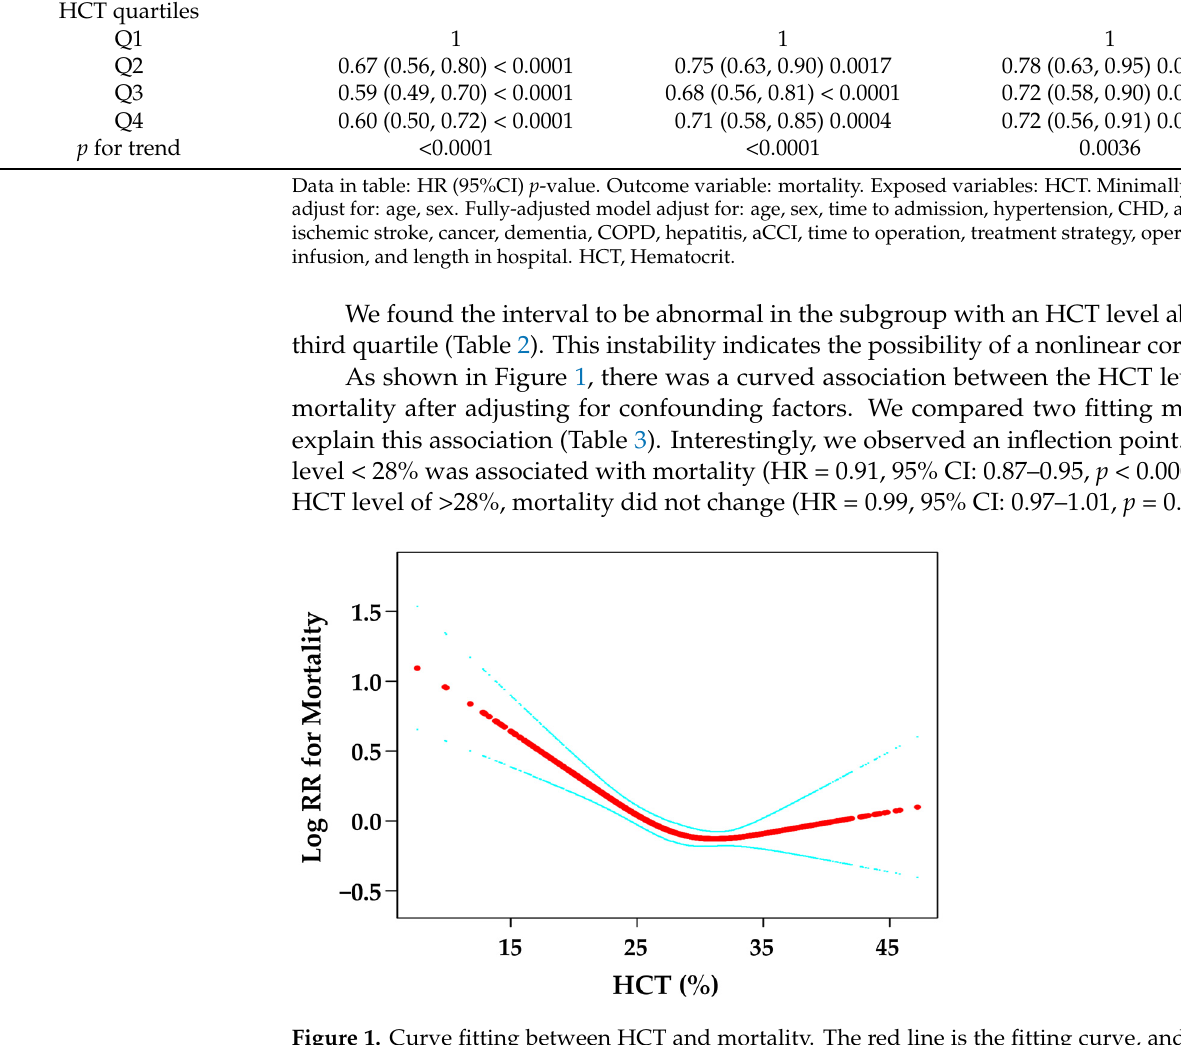
Figure 1. Curve fitting between HCT and mortality. The red line is the fitting curve, and the blue lines are 95%CI Table 3. Nonlinearity of HCT and mortality (N = 2589).